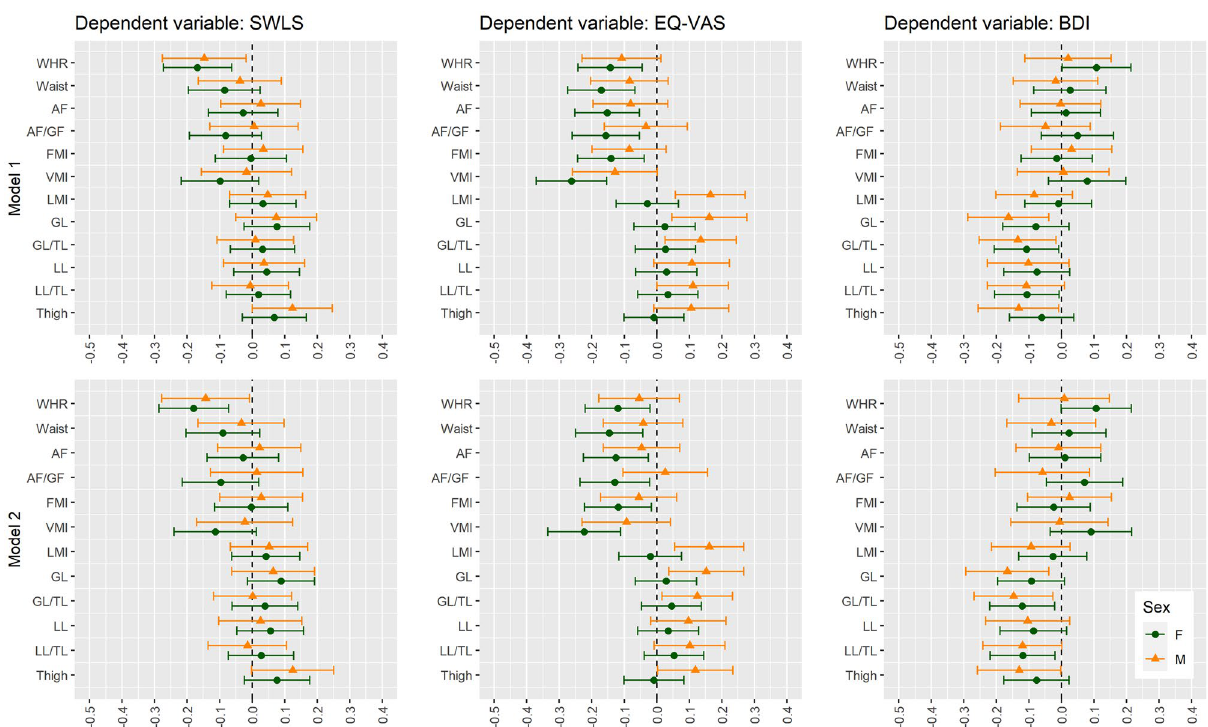
Figure 2. Multivariable linear regression analysis adjusted for age (Model 1) and by age, history of CVD, history of diabetes mellitus (Model 2) between body composition and subjective well-being scores in non-obese women and men. SWLS Satisfaction with Life Scale, EQ-VAS Euro Quality of Life Visual Analogue Scale, BDI Beck Depression Inventory, WHR waist-hip ratio, AF android fat, AF/GF android fat/gynoid fat, FMI Fat Mass Index, VMI Visceral Mass Index, LMI Lean Mass Index, GL gynoid lean, GL/TL gynoid lean/total lean, LL legs lean, LL/TL legs lean/total lean, F female, M male. Model 1: adjusted for age. Model 2: adjusted for age, history of cardiovascular diseases (i.e. arterial hypertension, atrial fibrillation, myocardial infarction, coronary heart disease, peripheral artery disease, stroke) and history of diabetes